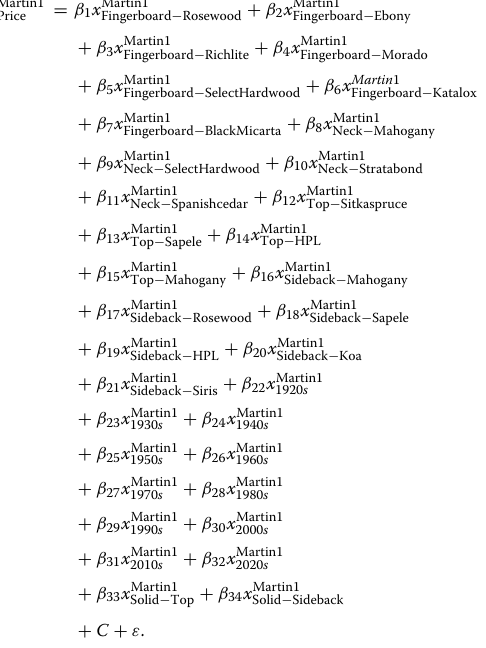
Model 2: Analysis 1 (the explanatory variables were the combination of wood species and guitar part